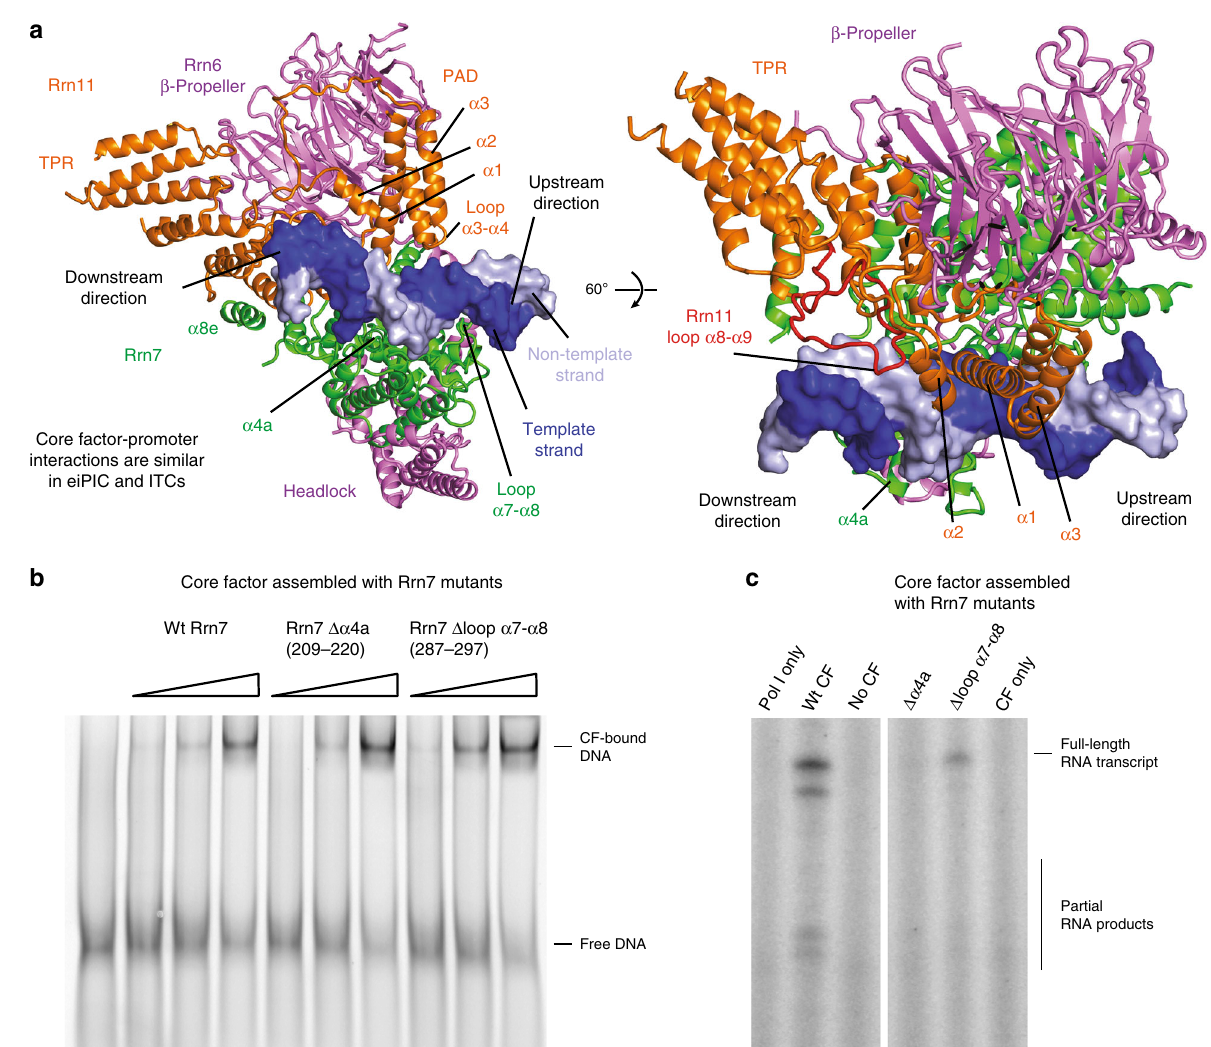
Fig. 2 Core Factor — promoter interactions in eiPIC. a Model of promoter-bound CF in the eiPIC. The same regions of Rrn7 and Rrn11 contribute to promoter phosphate backbone interactions compared to ITC reconstructions. b Electrophoretic mobility shift assay (EMSA) shows that wild-type CF interacts with double-stranded promoter DNA (0.25 pmol, 0.5 pmol, and 1 pmol CF added). Mutation of Rrn7 ( Δα 4a and Δ loop α 7- α 8) does not impair promoter-DNA association. c In contrast to DNA binding, initiation ef fi ciency of CF assembled with Rrn7 mutants Δα 4a and Δ loop α 7- α 8 is impaired (promoter-dependent in vitro transcription assay from a minimal